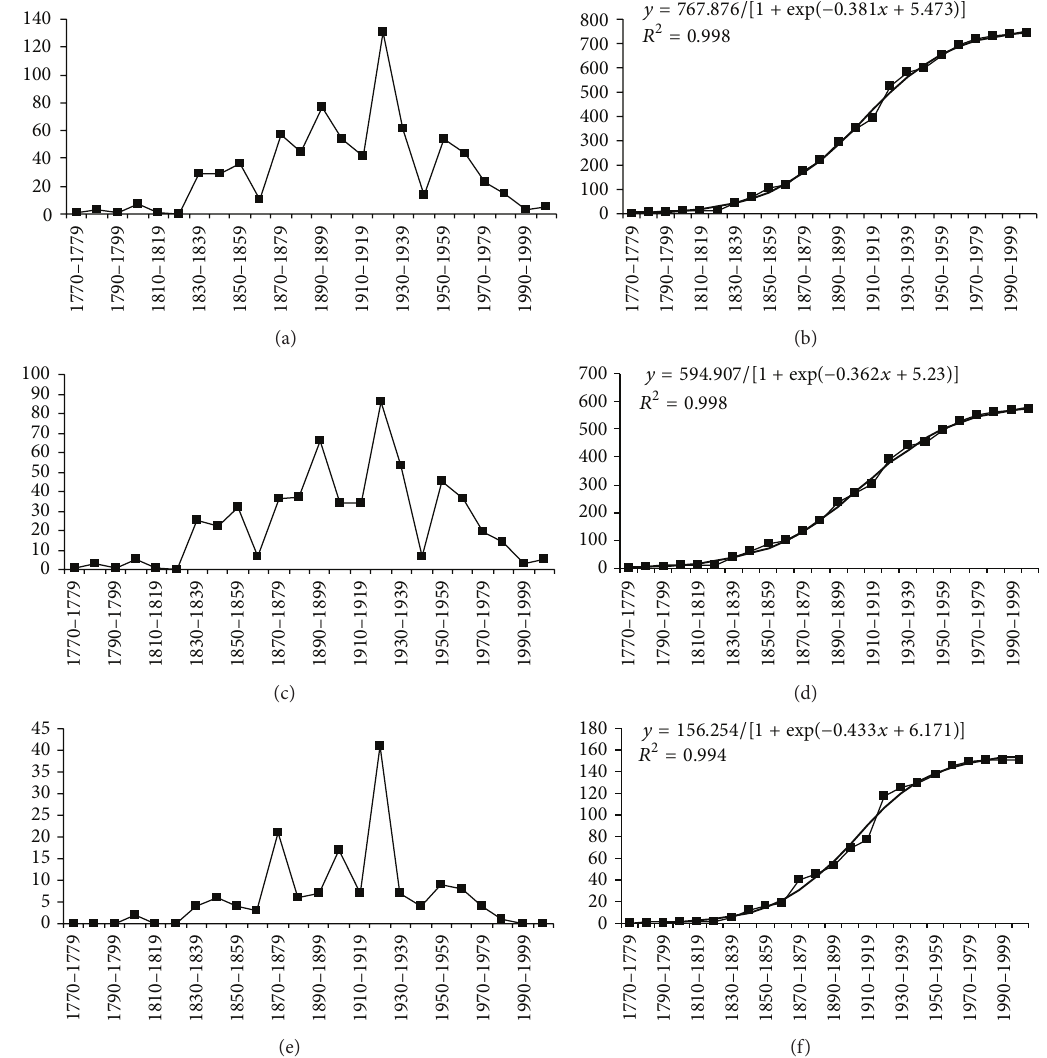
Figure 1: Numbers of total described taxa (a, b), valid species (c, d), and synonyms (e, f) of Paussini by decade. Figures (a), (c), and (e) report the absolute numbers, and Figures (b), (d), and (f) the cumulative numbers along with the equations of the fitted